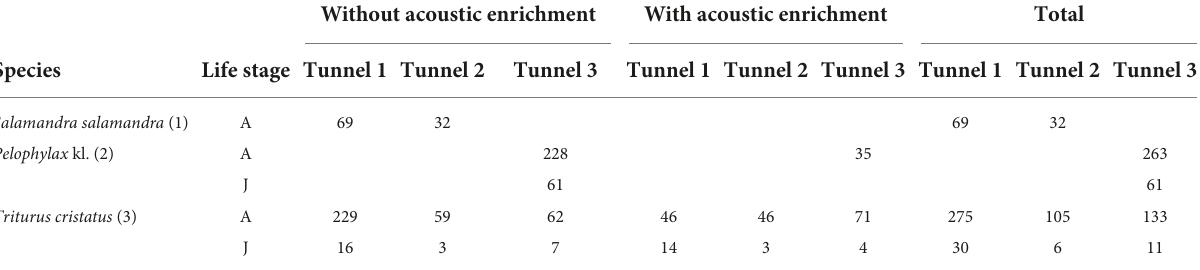
TABLE 1 Number of individuals of the three species tested in the different experiments.